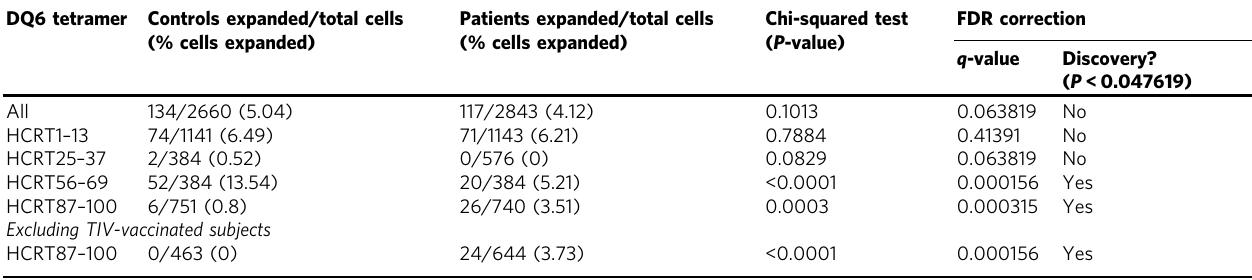
Table 2 Comparison of expanded clones from controls and patients analyzed using the chi-squared test DQ6 tetramer Controls expanded/total cells (% cells